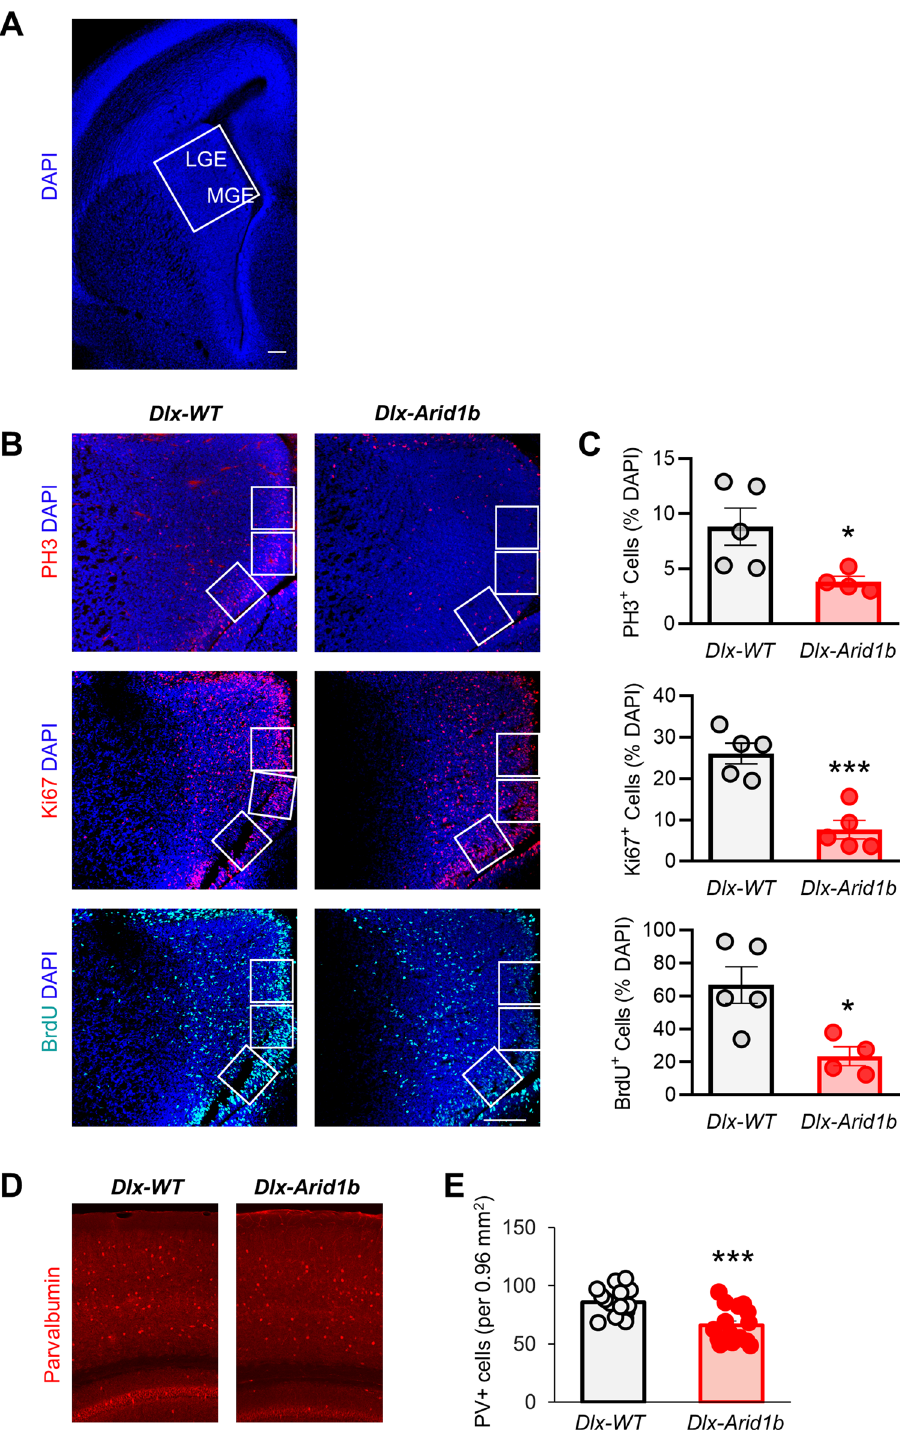
Figure 2. Arid1b deletion greatly decreases ventral progenitor proliferation. ( A ) Representative low magnification image demonstrating the location of brain sections examined in ( B ), including labeling of the LGE and MGE. ( B ) Immunostaining of coronal sections from E14.5 to 15.5 control and Arid1b LoxP/LoxP ;Dlx5/6-Cre ( Dlx-Arid1b ) brains with anti-phosphorylated Histone H3 (PH3), anti-Ki67 or anti-BrdU antibodies with DAPI co-stain. Representative images from both six control and Dlx-Arid1b brains for PH3, five from each genotype for Ki67, and five control and four Dlx-Arid1b brains for BrdU. Scale bars: 50 μm. White boxes (2.5 mm 2 ) indicate regions of interest in the VZ of the MGE that were quantified and averaged for each animal. ( C ) Quantifications of the percentage of DAPI-positive cells co-labeled with the indicated antibody for panels in ( B ). N = 6 mice for each condition for PH3, N = 5 for each genotype in Ki67, and N = 5 mice for control and 4 for BrdU. Sections were co-immunostained for DAPI, BrdU and PH3/Ki67. ( D ) Cortical sections of P30 Dlx-Arid1b and their WT controls were immunostained with a parvalbumin antibody. ( E ) Quantification of ( D ). N = 15 mice for each condition. Statistical significance was determined by two-tailed Student’s t test. Error bars show standard error of the mean (SEM). * p < 0.05, *** p <